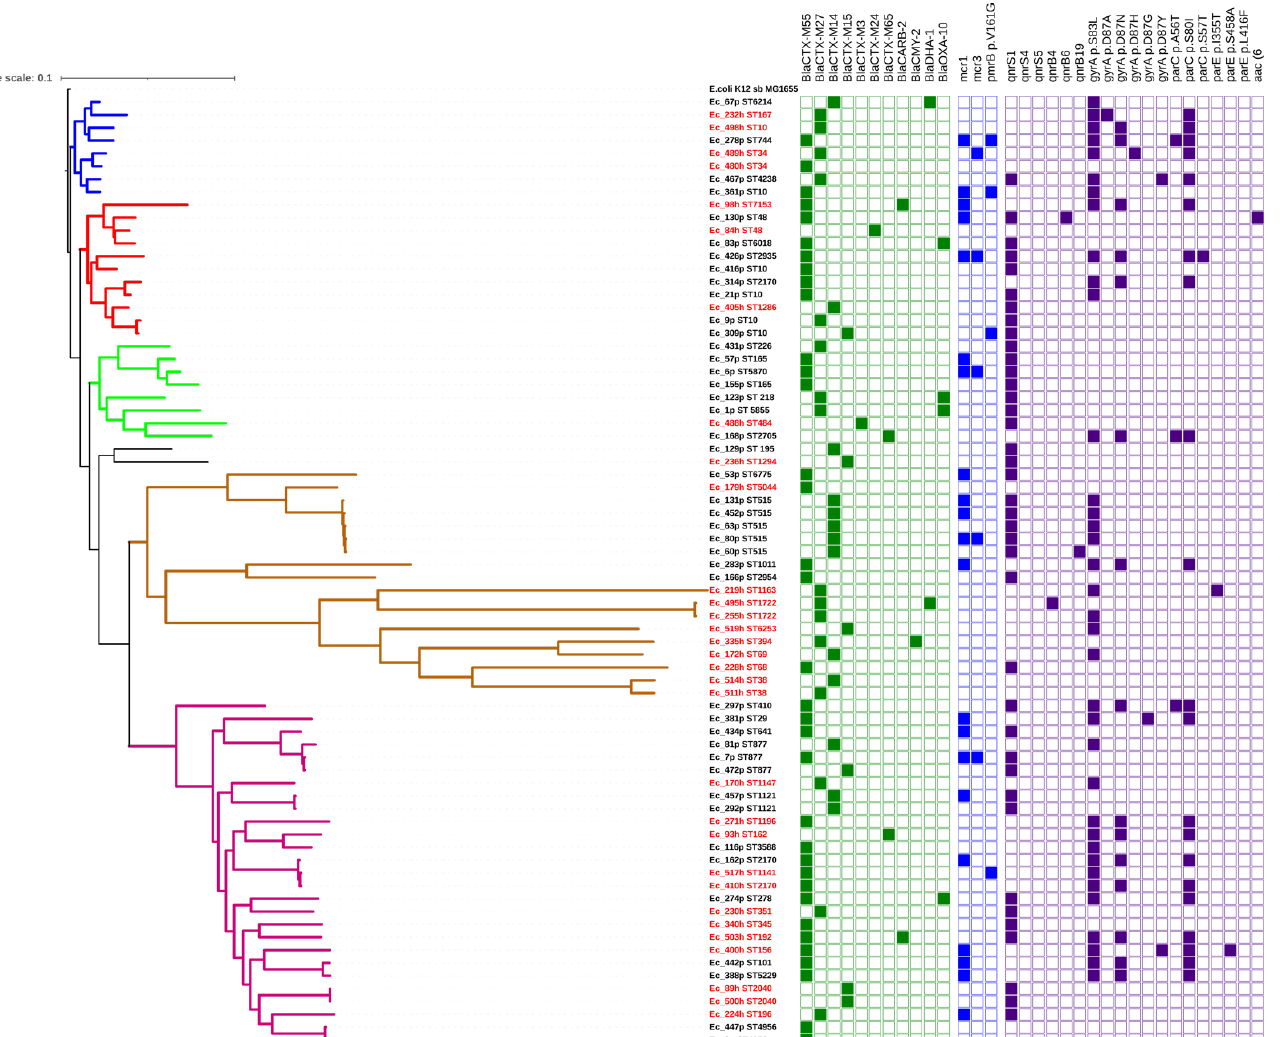
Figure 2. Phylogeny of ESBL-producing E. coli from pigs and pig farm workers. The isolates from workers are shown with red font node labels and the pig isolates are in black. The squares to the right indicate gene presence (full square) and absence (empty square). Note: green, ESBL genes; blue, plasmid-mediated colistin resistance genes and mutations; and purple, quinolone resistance (plasmid-mediated genes and point mutations). The color distinctions of the tree branches distinguish six main clusters in which the 74 isolates were regrouped.